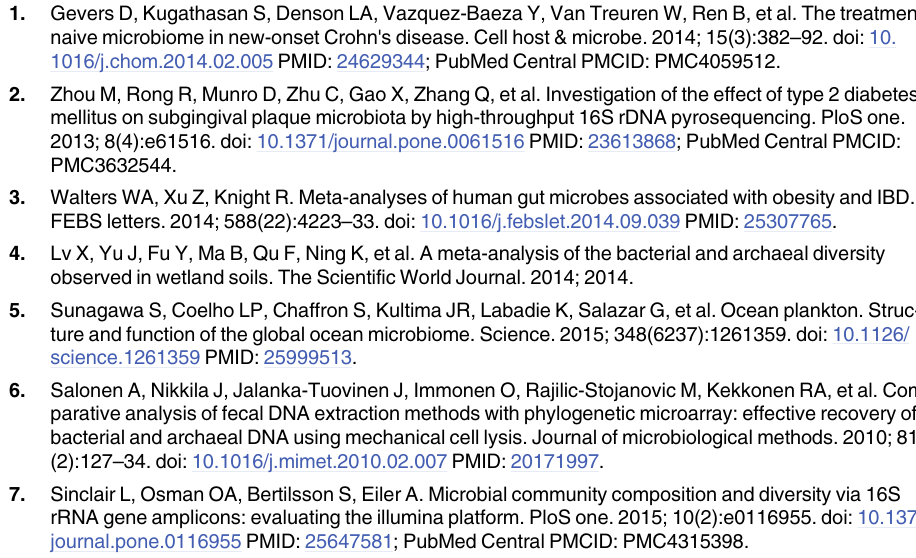
S1 Table. PCR primer, linker and adaptor sequences used for sequencing samples on the PGM Ion Torrent and Illumina MiSeq. The table also contains the PCR conditions for 16S rRNA gene amlification and sequence length for quality filtering during read processing. S2 Table. Statistical comparisons of taxonomic assignments between the various clusters from Fig 1. A Mann-whitney test was used to analyse differences and the P-values were cor- rected for multiple testing using Benjamini and Hochberg. S3 Table. The N50 values obtained post assembly, via IDBA_UD, for the PGM Ion Torrent, Illumina HiSeq and MiSeq at various read sub-sampling